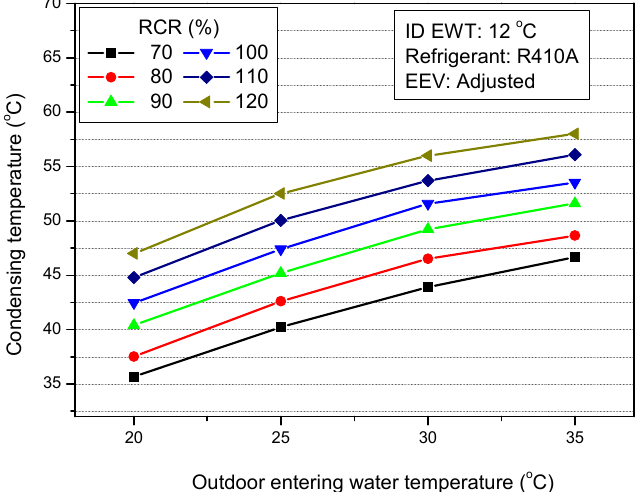
Energies 2018 , 11 , x FOR PEER REVIEW Figure 25. Condensing temperature with variation of T OD in cooling mode. Figure 25. Condensing temperature with variation of T (cid:2899)(cid:2888) in cooling mode.